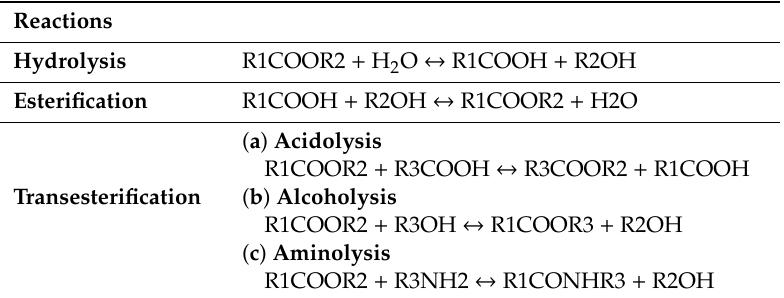
Table 1. Reactions catalysed by